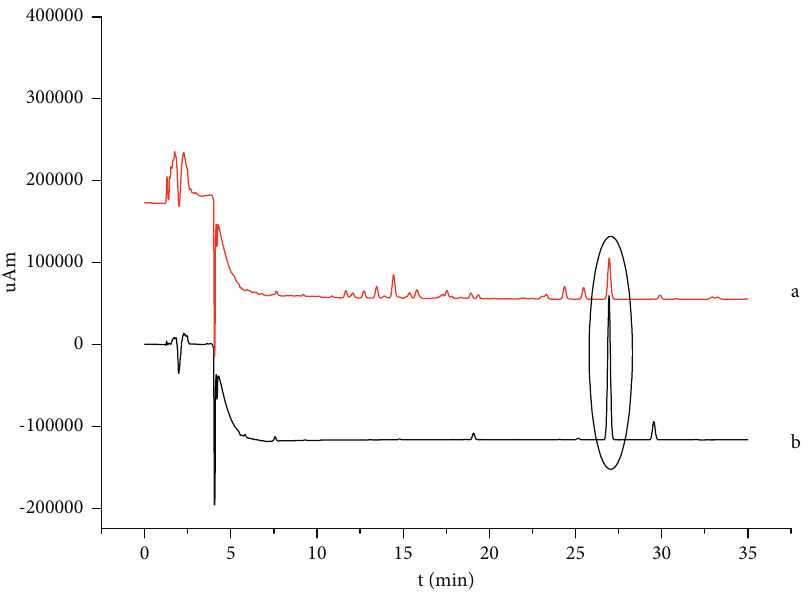
Figure 1: Chromatogram of (a) Poria sample and (b) reference solution.